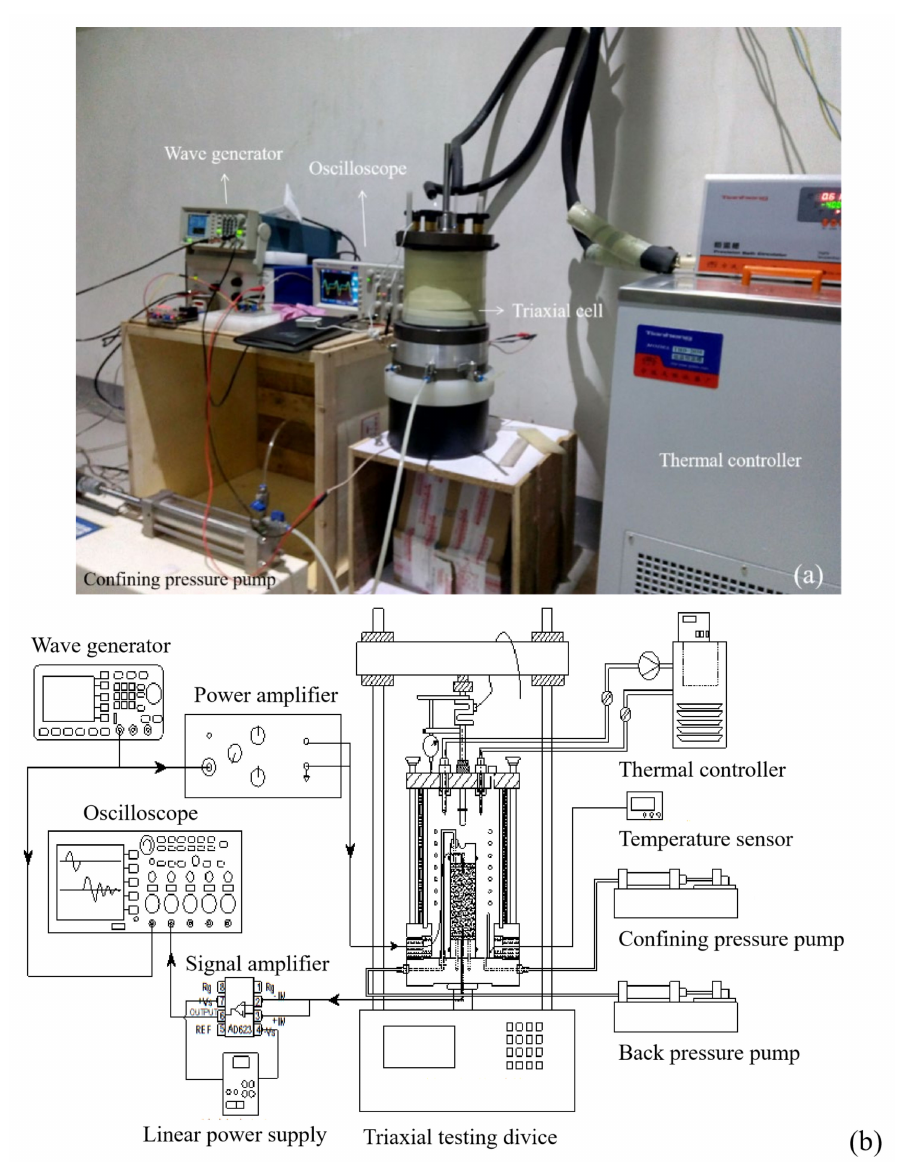
Figure 4. ( a ) Photo and ( b ) schematic setup of the bender element test